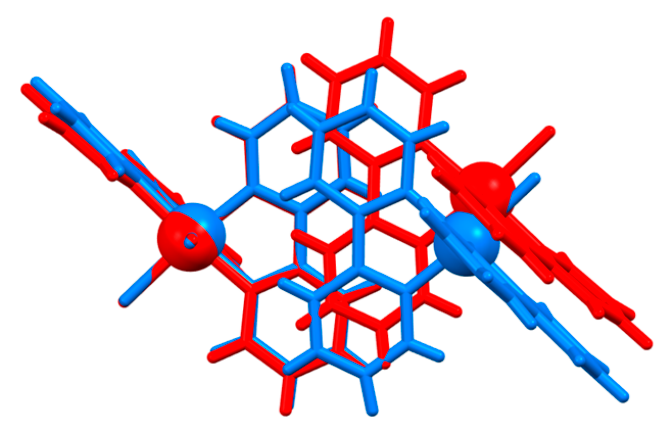
Figure 8. Overlay of the dimeric units in cis- [Ru(bpy) 2 Cl 2 ] · 3.5H 2 O (CSD refcode DOGMOB [4]) shown in blue and in cis- [Ru(bpy) 2 Cl 2 ] · 1.7I 2 (CSD refcode OCERUK [42]) displayed in red. The molecules on the left are overlaid using pairs of Ru and Cl atoms in Mercury [23]. This reveals the greater offset nature of the bpy...bpy π -stacking interaction in cis- [Ru(bpy) 2 Cl 2 ] · 1.7I 2 (red) versus cis- [Ru(bpy) 2 Cl 2 ] · 3.5H 2 O